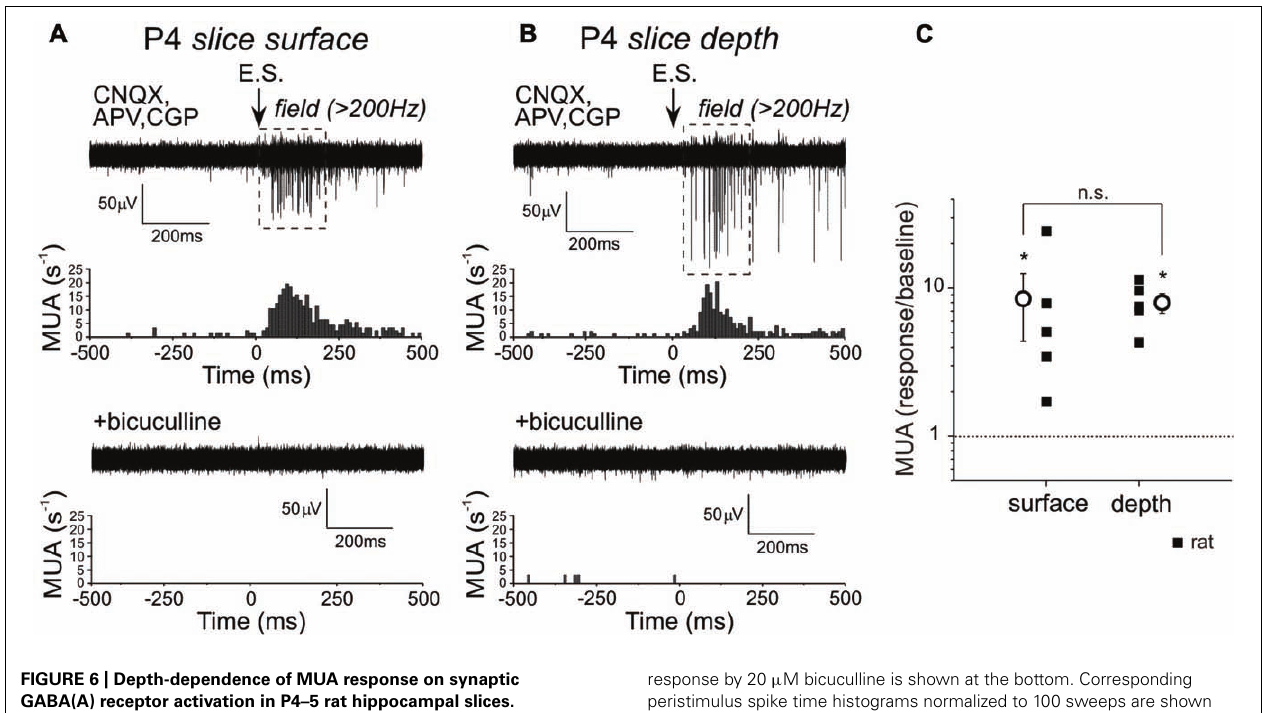
FIGURE 6 | Depth-dependence of MUA response on synaptic GABA(A) receptor activation in P4–5 rat hippocampal slices. (A,B) Example field potential recording of MUA response evoked by electrical stimulation (E.S.) at the surface (A) and in the core (B) of a P4 hippocampal slice in the presence of ionotropic glutamate and GABA(B) receptor antagonists (CNQX, APV, CGP55845). Suppression of MUA